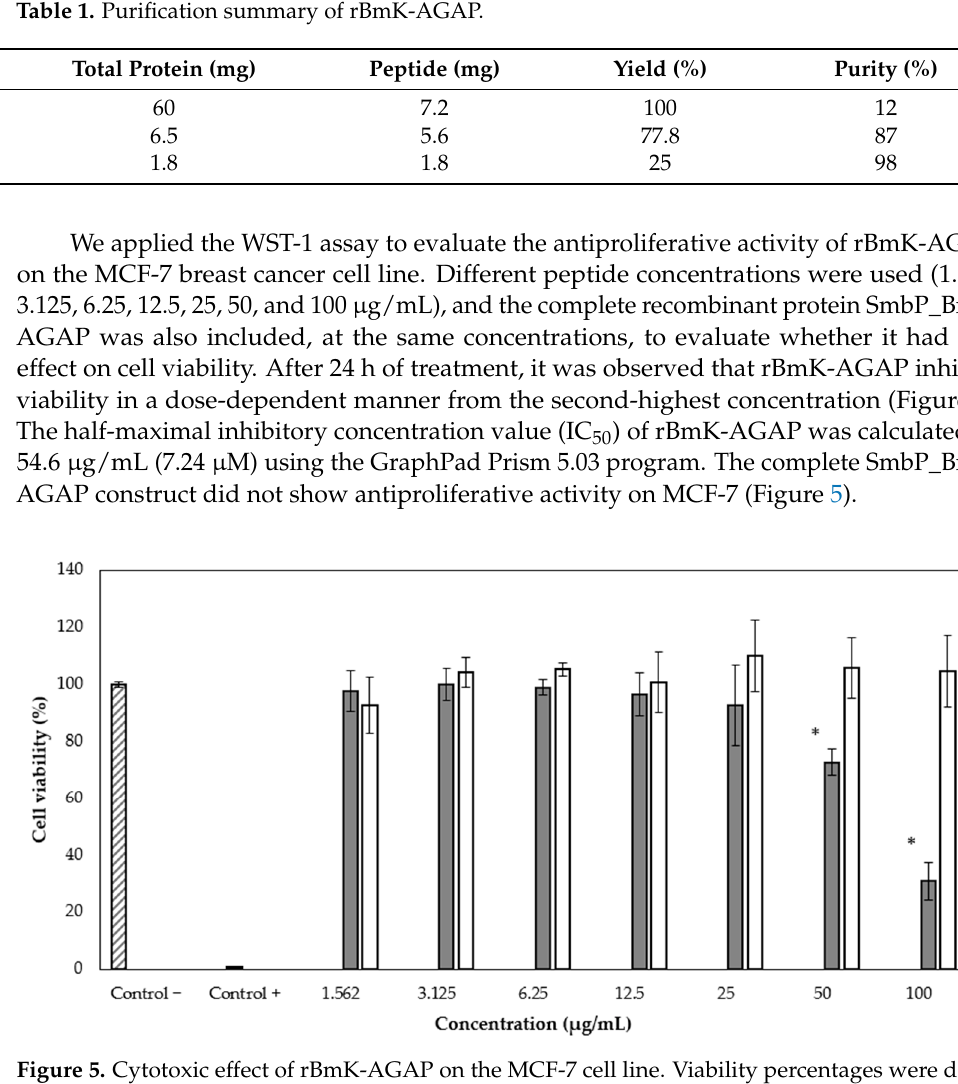
Figure 5. Cytotoxic effect of rBmK-AGAP on the MCF-7 cell line. Viability percentages were deter- mined by the cytotoxicity test using the WST-1 reagent. rBmK-AGAP (gray bar) and SmbP_BmK- AGAP (white bar). * ANOVA considered a value of p < 0.05 statistically significant vs. the negative control.